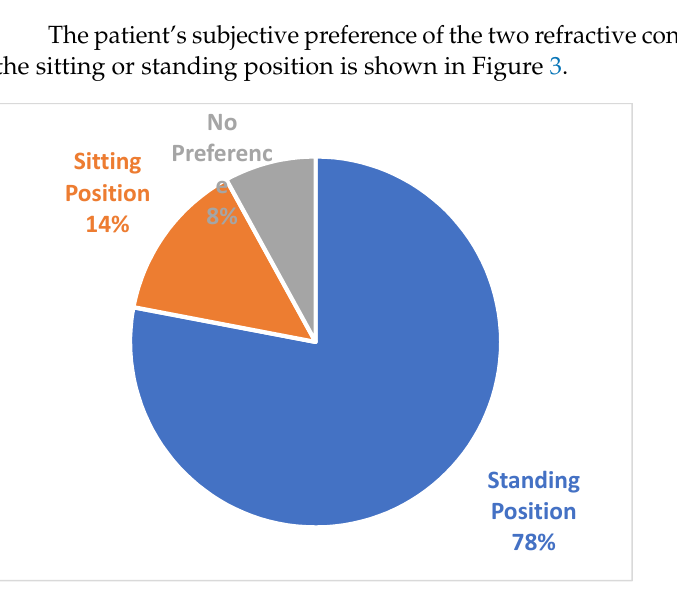
Figure 3. Patients’ subjective preference of the trial lenses.